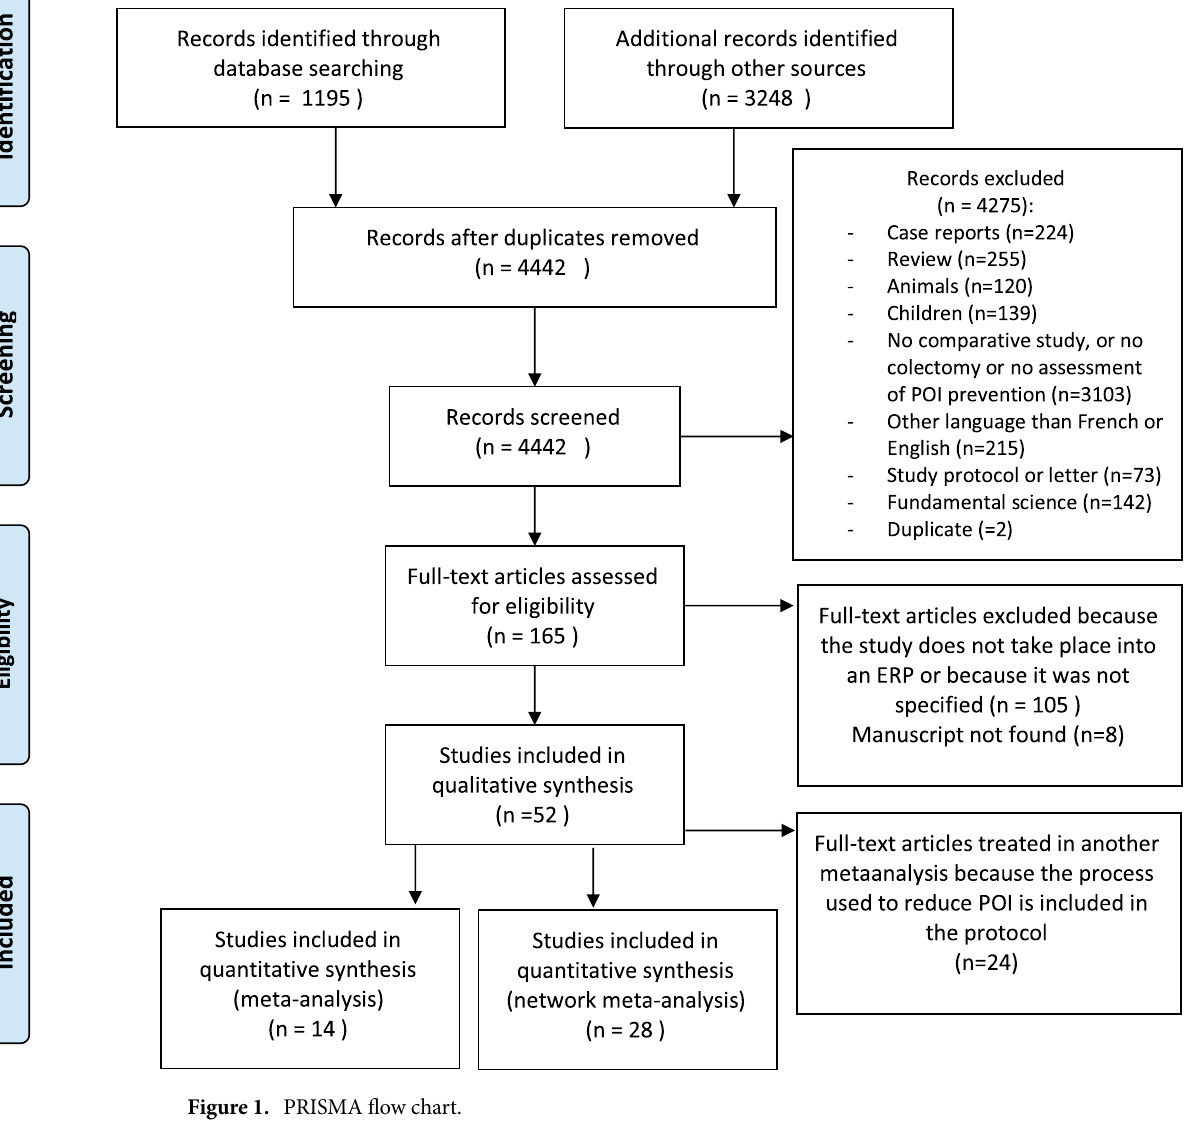
Figure 1. PRISMA flow